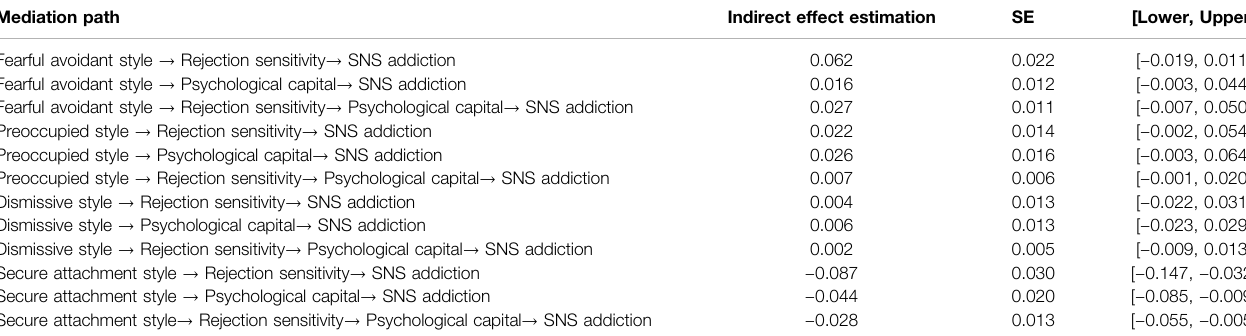
TABLE 5 | Multiple mediating effects of four dimensions of attachment style and 95% con fi dence intervals (N (cid:1) 607). Mediation path